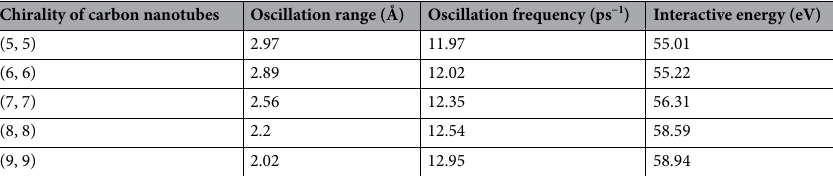
Chirality of carbon nanotubes